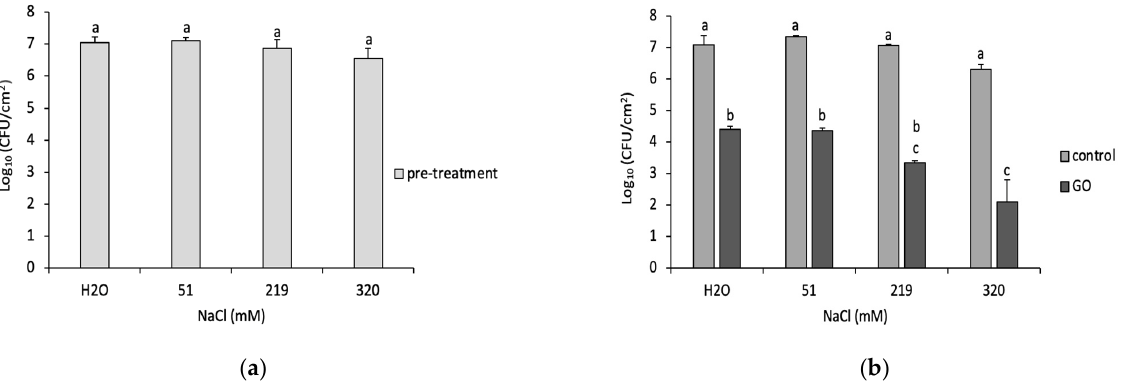
Figure 4. Impact of different osmotic pressure on P. putida biofilm cells ( a ) The viability of biofilm after the exposure to different NaCl concentration (pre-treatment). ( b ) The viability of biofilm after the exposure to constant NaCl concentrations (51, 219 and 320 mM) and incubation with either deionized water (control) or 85 mg/mL GO for 24 h (post-treatment). Mean values with different letters are significantly different ( p < 0.05). Similar letters are non-significantly different. The data were analyzed with one-way